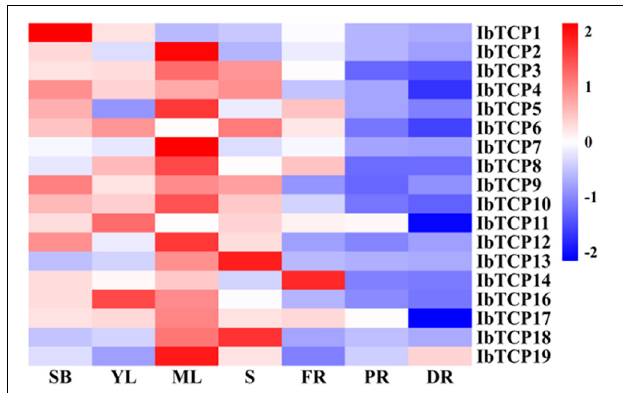
FIGURE 4 | Heatmap representation of the gene expression of 18 IbTCPs in various tissues. The tissues used for transcription pattern analysis are listed at the bottom, shoot buds (SB), young leaves (YL), mature leaves (ML), stems (S), fibrous roots (FR), pencil roots (PR), and developing roots (DR). The genes are listed on the right of the expression